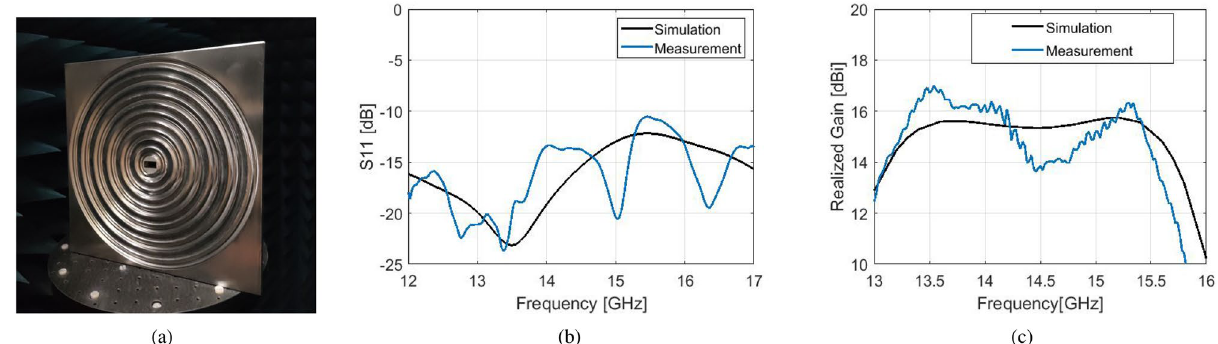
Figure 8. ( a ) Fabricated prototype of the hybrid corrugated antenna with flat gain response. ( b ) Measured S 11 versus simulated. ( c ) Measured gain versus simulated.